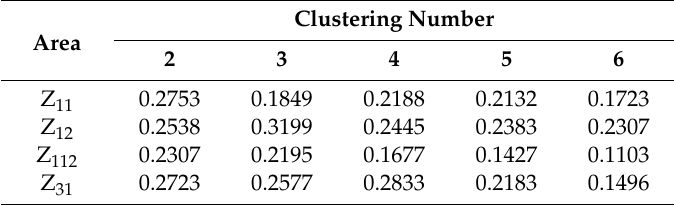
Table 5. BWP index of Z 11 , Z 12 , Z 112 and Z 31 with di ff erent number of clusters.